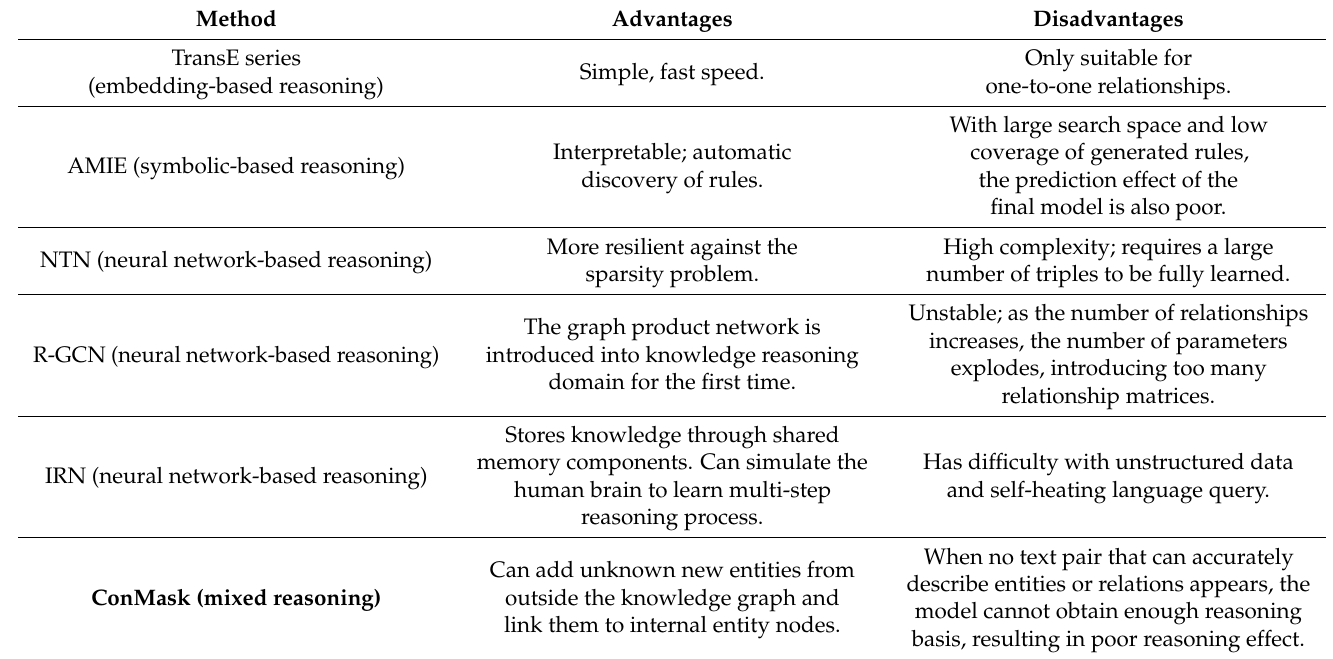
Table 1. Comparison and analysis of knowledge graph reasoning methods. Bold indicates that the method is